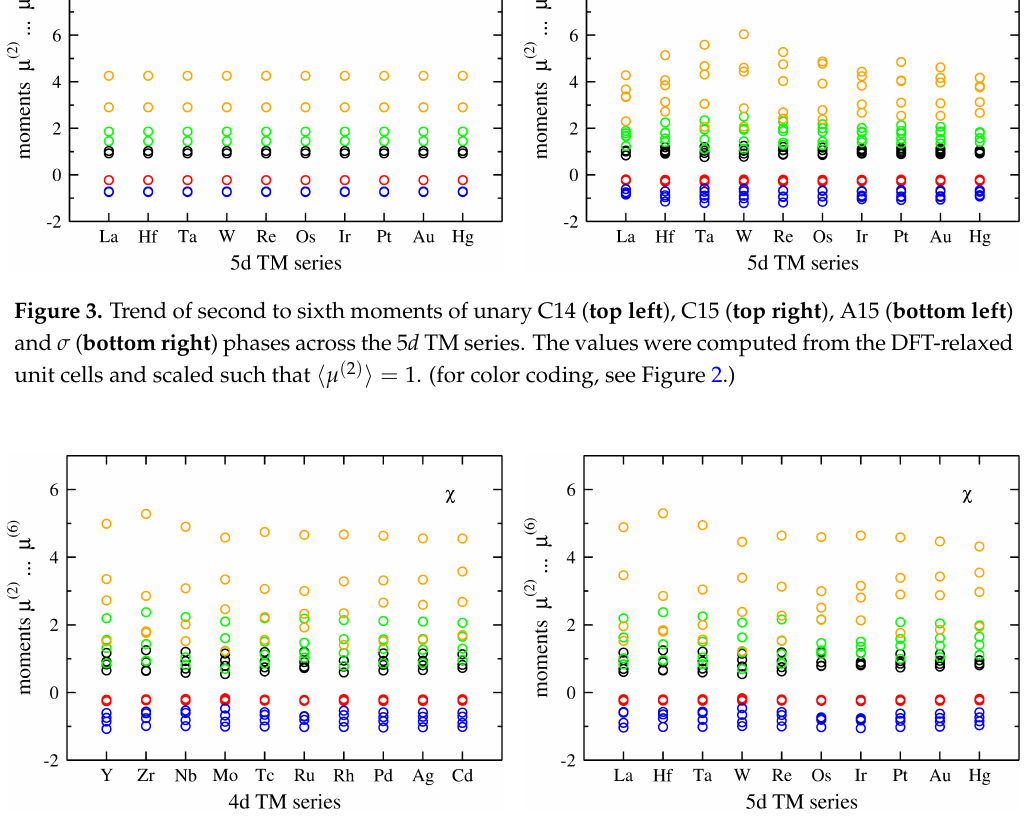
Figure 4. Comparison of second to sixth moments of the χ phase across the 4 d ( left ) and 5 d ( right ) TM series using the DFT-relaxed unit cells with scaling such that (cid:104) µ ( 2 ) (cid:105) = 1. (for color coding, see Figure